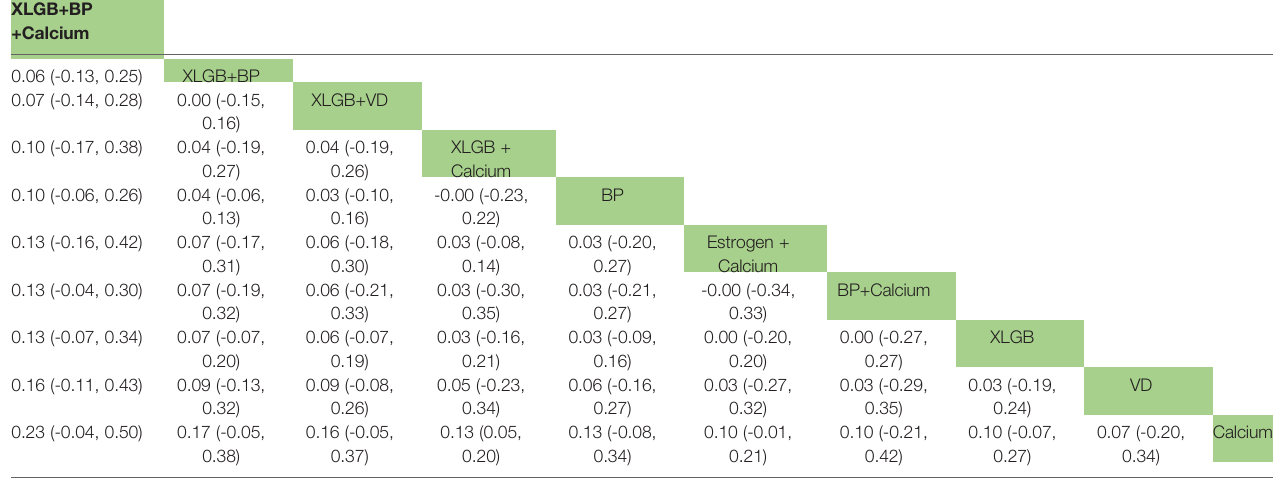
TABLE 7 | Network meta-analysis of lumbar BMD. XLGB+BP